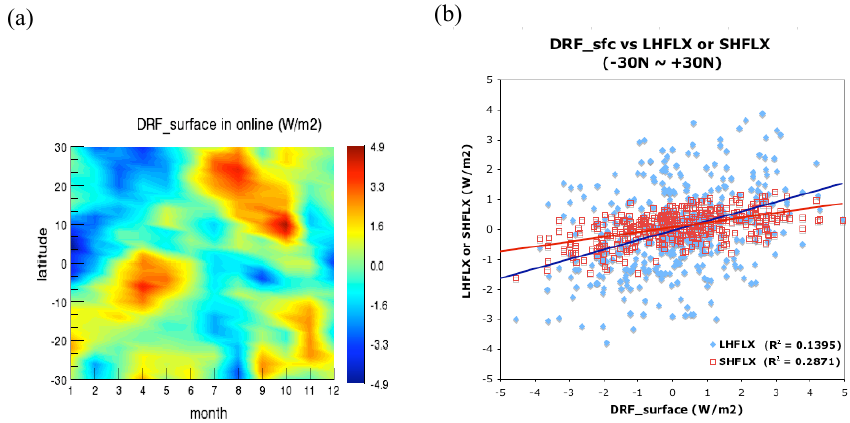
Fig. 10. (a) Hovm¨oller diagram of zonal monthly means in tropical region (30S–30N) of difference in direct radiative forcing ( 1 DRF) at the surface due to seasonal BBCA emissions. (b) The scatter plot of 1 DRF at the surface against the differences in latent heat flux ( 1 LHFLX, filled blue) and sensible heat flux ( 1 SHFLX, open red). All the values are zonal monthly average over 20 years in the online